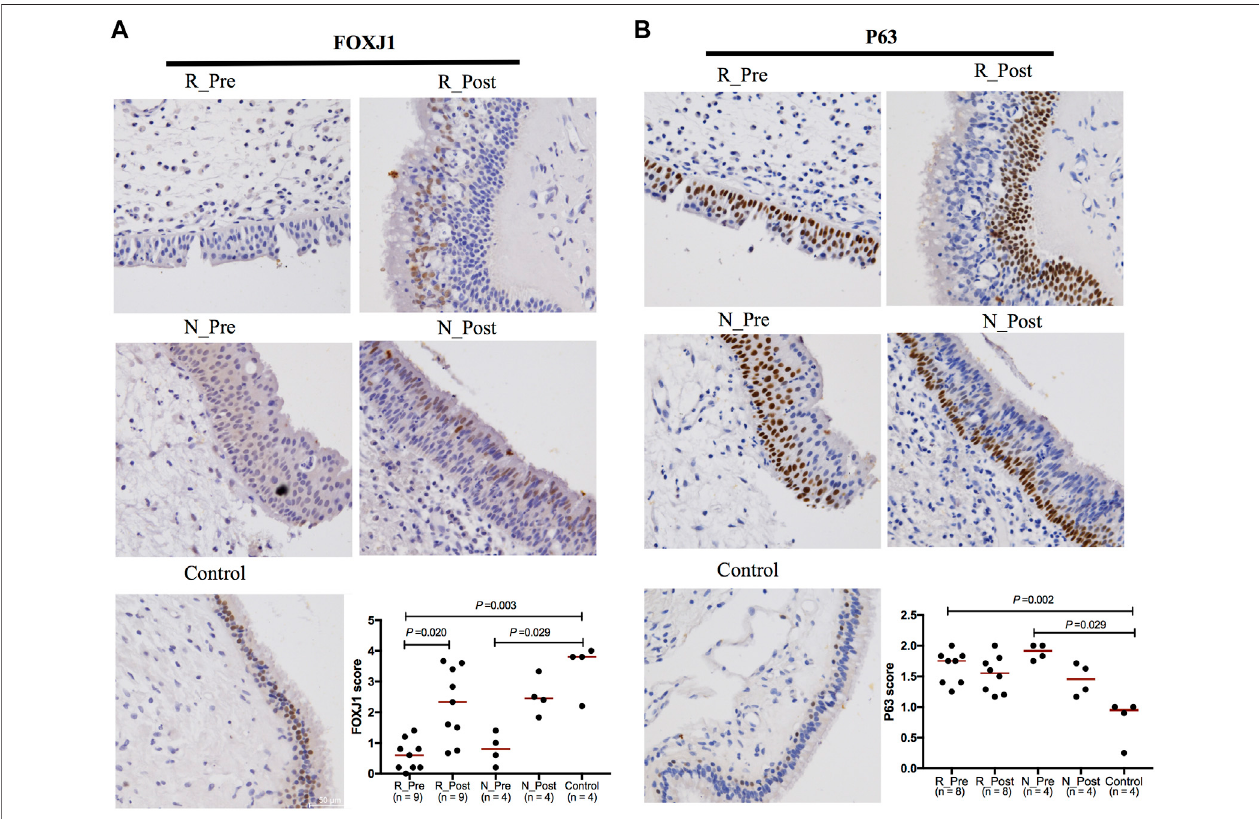
FIGURE 3 | Expression of FOXJ1 and P63 determined by immunohistochemistry. Representative immunostaining images and analysis of the semiquantitative scores for the ciliated cell marker FOXJ1 (A) and basal cell marker P63 (B) . Wilcoxon matched-pairs signed rank test was used to compare two groups of paired data. Mann-Whitney U test was used for the comparison of unpaired data. The median values of the semiquantitative scores were indicated by horizontal red lines.